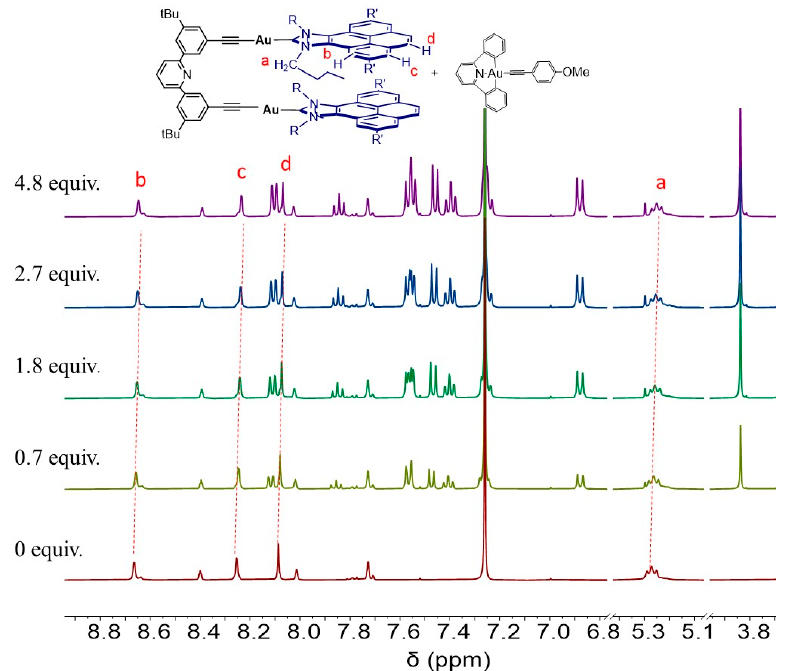
Figure 1. Selected region of the 1 H NMR spectra resulting from the titration (CDCl 3 ) of 2 with 3 .